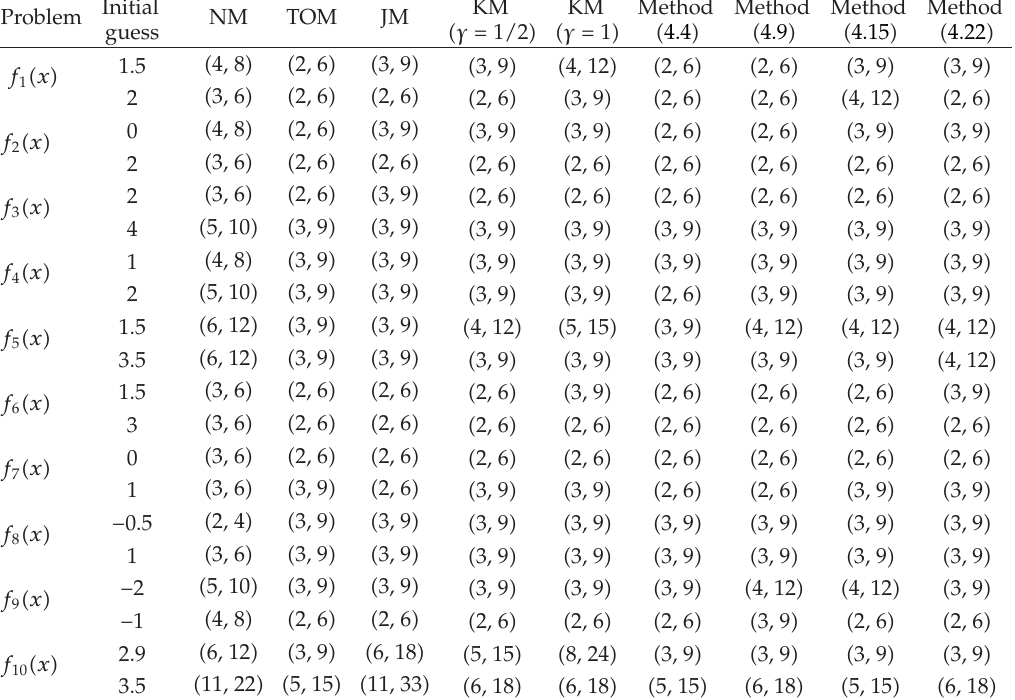
Table 2: Total number of iterations to approximate the zero of a function and the total number of function evaluations for various multipoint iterative